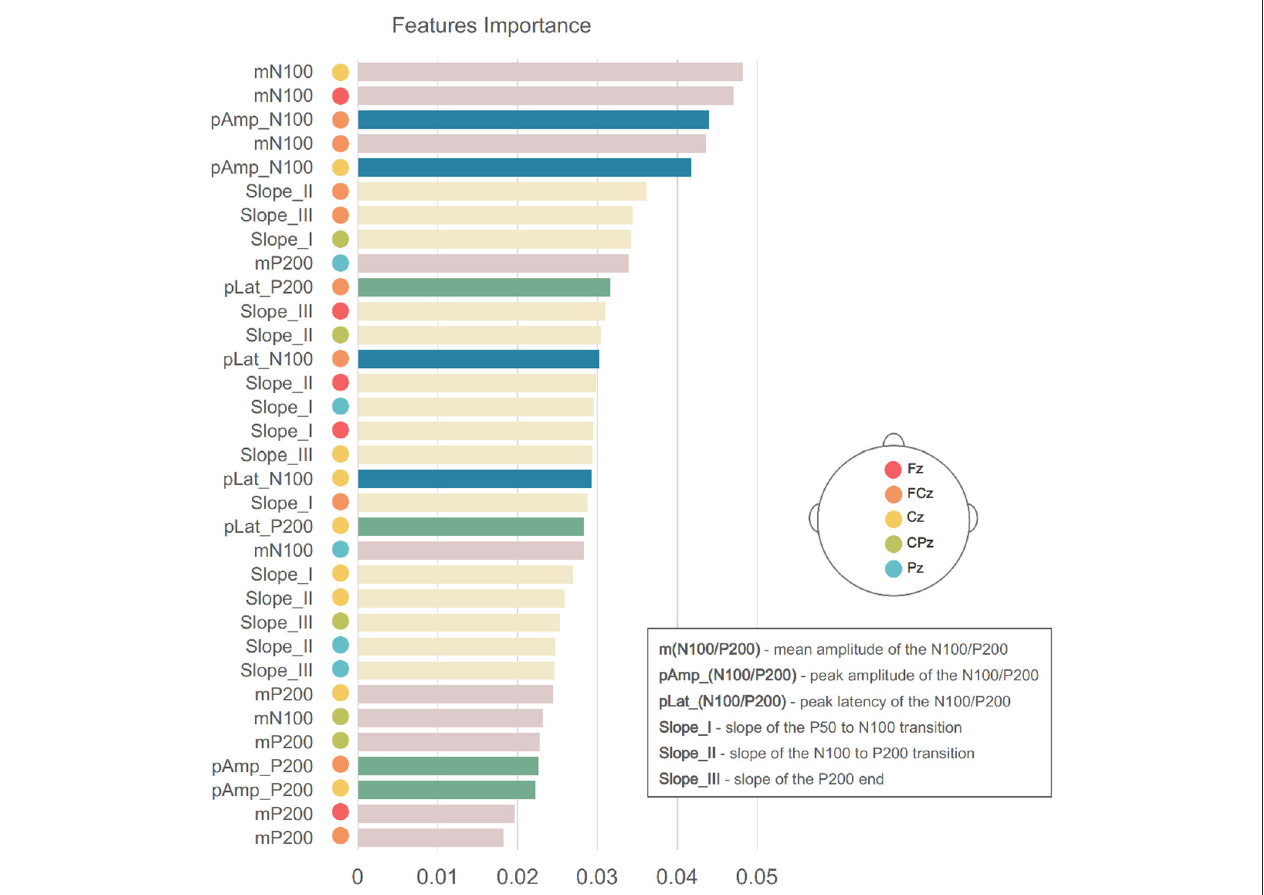
FIGURE 10 | Importance of each feature given by its weight to final performance of RF using 33 features. Bars colors corresponds to the colors used in Figure 5 .